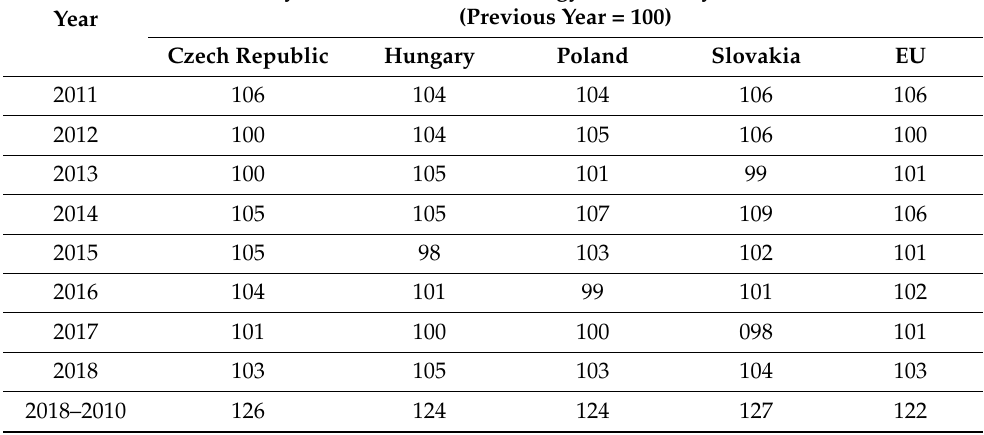
Table 2. The chain dynamic indicators for energy productivity in the Visegrad group countries. Chain Dynamic Indicators for Energy Productivity in Countries in Years (Previous Year = 100) Year Czech Republic Hungary Poland Slovakia EU 2011 106 104 104 106 106 2012 100 104 105 106 100 2013 100 105 101 99 101 2014 105 105 107 109 106 2015 105 98 103 102 101 2016 104 101 99 101 102 2017 101 2018 103 105 103 104 103 2018–2010 126 124 124 127